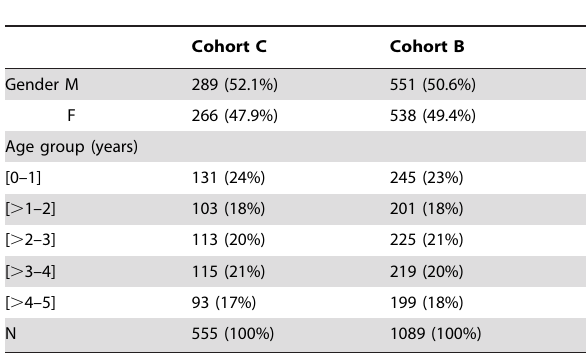
Table 1. Characteristics of children at